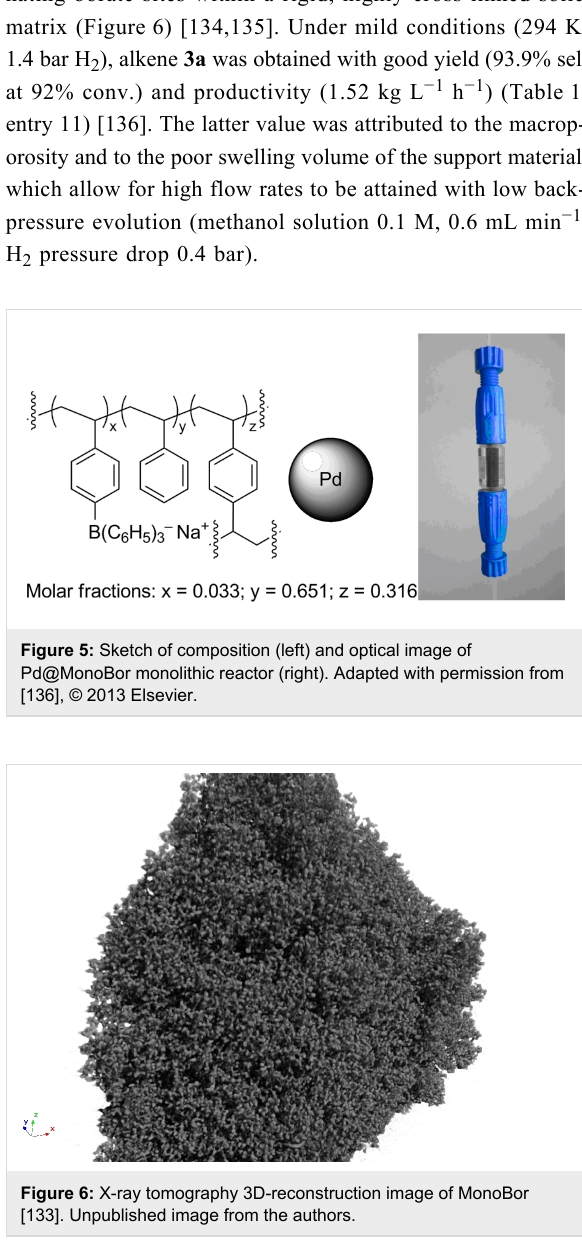
The highest productivity in the continuous partial hydrogena-